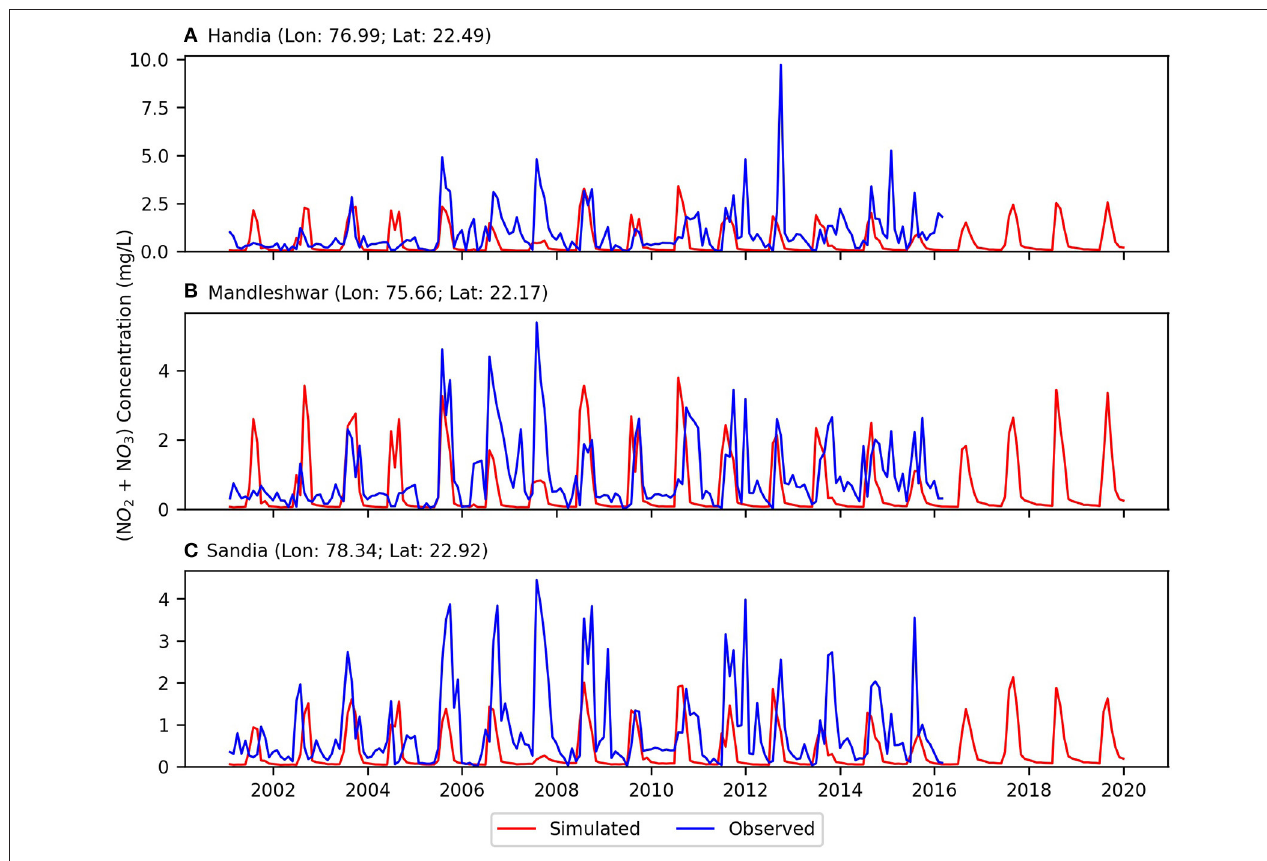
FIGURE 6 | (A–C) : Time series of (NO 2 + NO 3 ) concentration for comparison between SWAT simulated nutrients and CWC observed nutrient